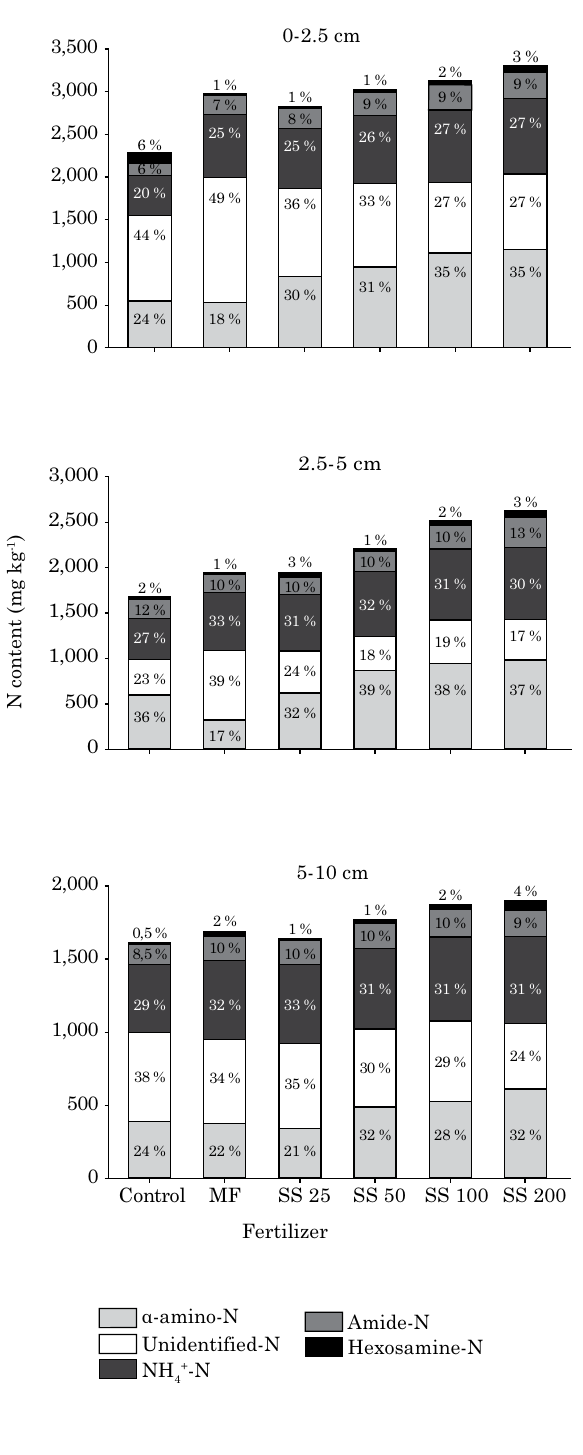
Figure 3. Proportion of forms of organic n in the soil in relation to hydrolyzed-n in the soil in the layers up to 10 cm depth in a latossolo Vermelho distroférrico (Typic Hapludox) subjected to 10 years of annual fertilization with mineral fertilizer (mF) and pig slurry (SS) at the rates of 0 (control), 25, 50, 100, and 200 m -3 ha -1 in a no-till system. mean value of four